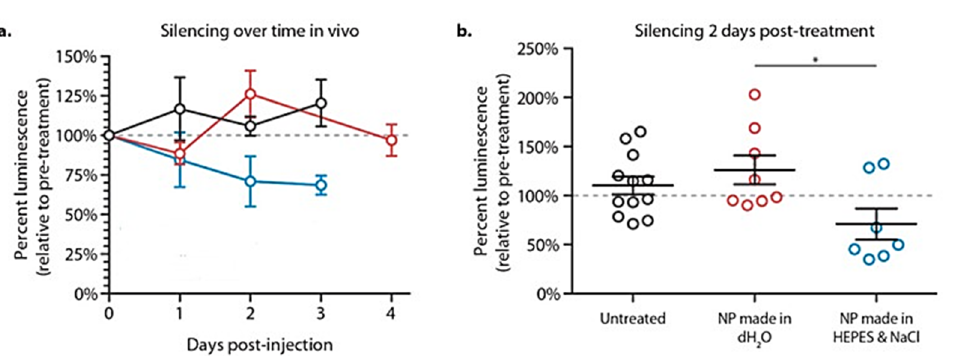
Figure 9. ( a ) Temporal evolution of the gene silencing effect of liposomes loaded with a 21-base-pair locked nucleic acid siRNA analogue on the human ovarian cancer cell line OVCAR8 depending on their preparation protocol: untreated (black symbols), assembled in deuterated water (red symbols) and assembled in HEPES and NaCl (blue symbols9 ( b ) Gene silencing effect of liposomes loaded with 21-base-pair locked nucleic acid siRNA analogue on the human ovarian cancer cell line OVCAR8 depending on their preparation protocol after two days of their injection. Reprinted with permission from reference [260]. Copyright (2019), with permission from American Chemical Society.